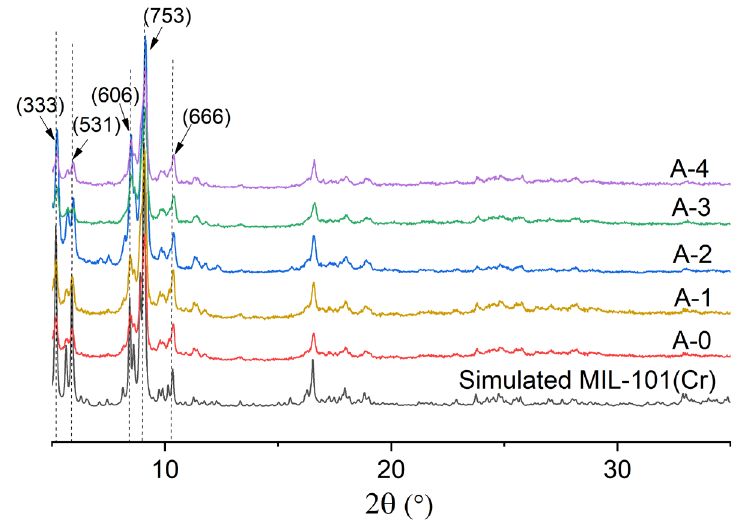
Figure 1. XRD patterns of the samples compared with the simulated XRD pattern.